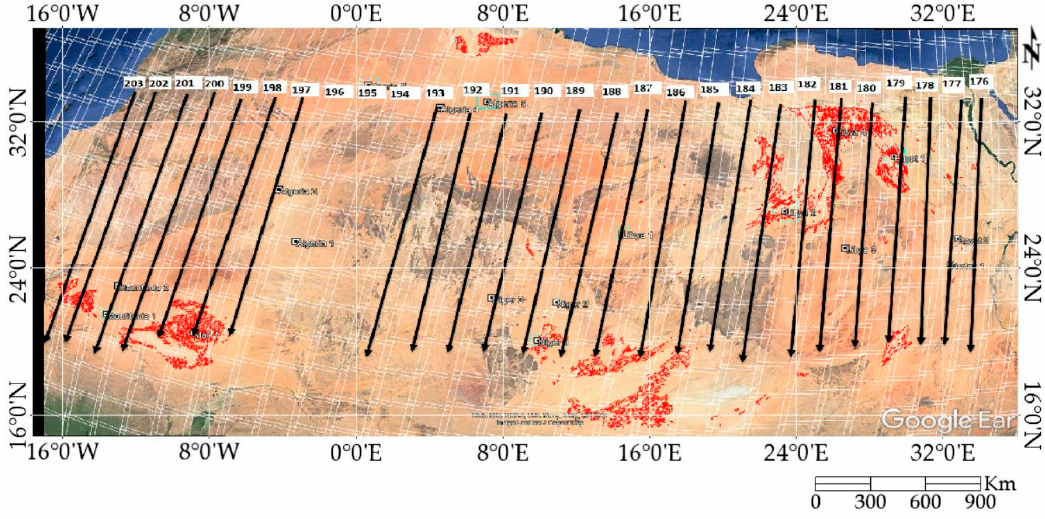
Figure 9. Cluster 13 coverage over North Africa and corresponding WRS2 paths and rows.